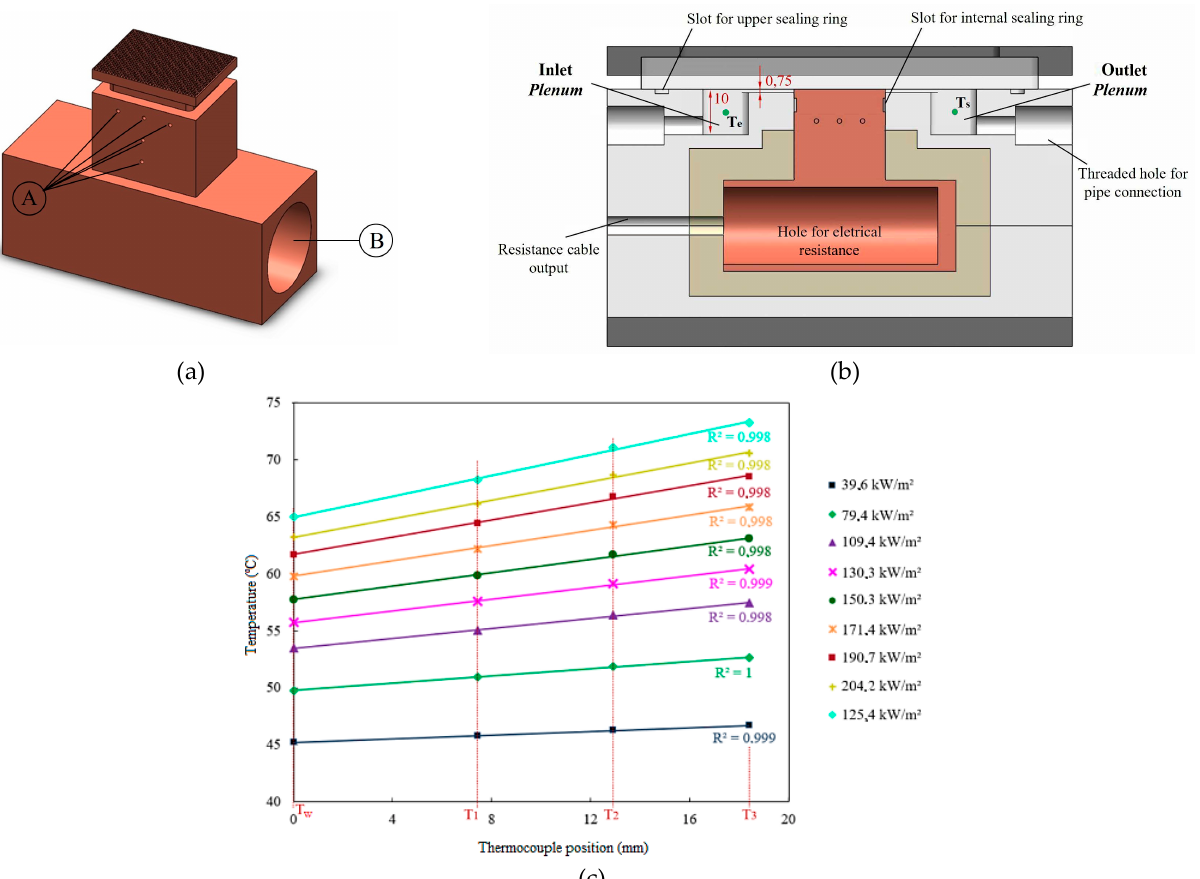
Figure 2. Design of the microfinned heat sink. ( a ) Isometric view; ( b ) front view with internal details (measurements in mm); ( c ) linear temperature profiles used to estimate the wall temperatures.